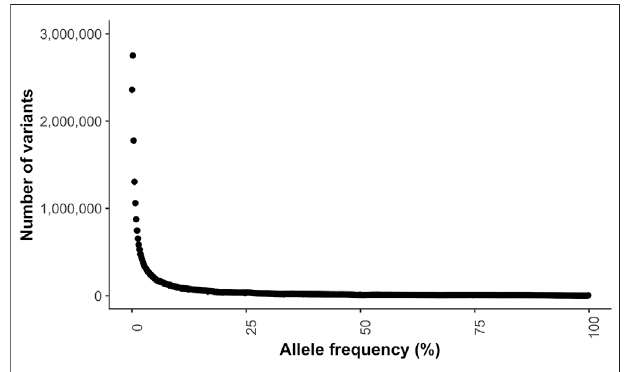
FIGURE 3 | Minor allele frequency distribution of the